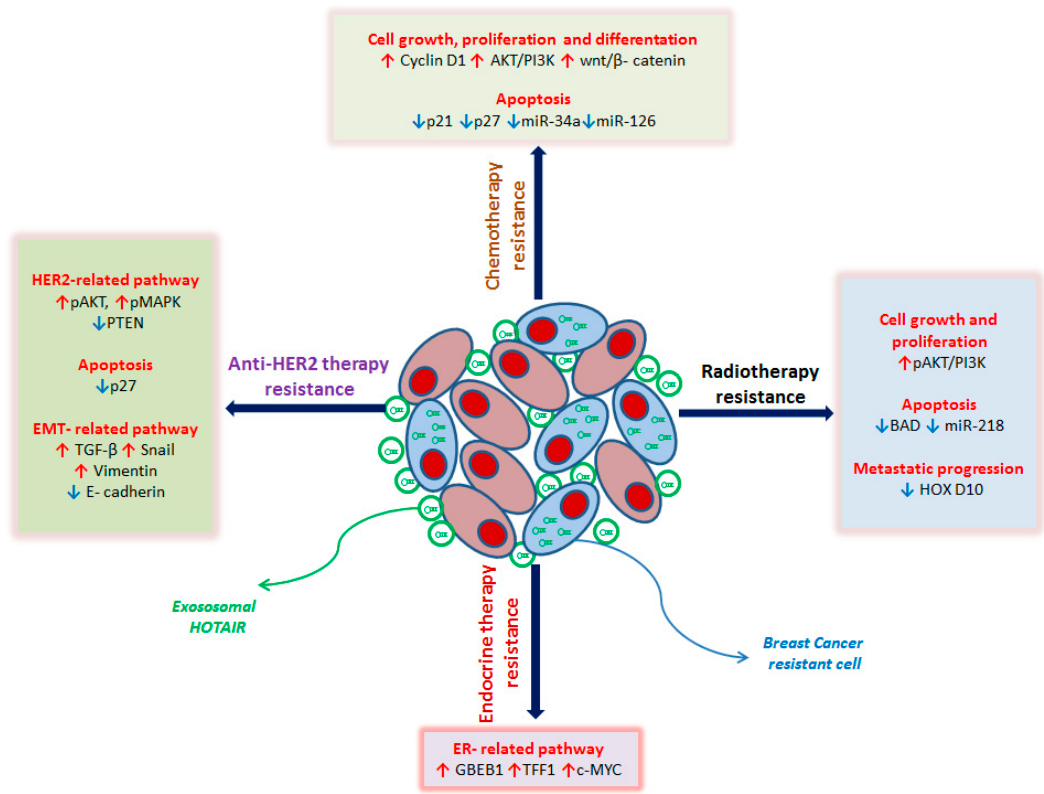
Figure 1. Schematic representation of HOTAIR role in breast cancer (BC) drug resistance mechanisms with details of the main molecular pathways involved. In anti-HER2 treatment-resistant BC cells, the overexpression of HOTAIR leads to: (i) deregulation of HER2-related genes by upregulating the signal transduction pathway PI3K-Akt and downregulating the tumor suppressor gene PTEN with the consequent increase in proliferation, cell growth, and survival; (ii) inhibition of apoptosis by the downregulation of cyclin-dependent kinase inhibitor p27; (iii) induction of EMT by TGF- β , Snail and Vimentin upregulation, and decrease in E-cadherin expression. In endocrine therapy resistant BC cells, the overexpression of HOTAIR leads to the repression of ER and the activation of ER-responsive genes, such as GREB1, TFF1 , and c-MYC , promoting cell proliferation. In BC radio- resistant cells, the overexpression of HOTAIR leads to: (i) promotion of cell growth and proliferation by upregulation of the PI3K-Akt pathway; (ii) blockage of apoptosis by downregulating the pro- apoptosis gene BAD and miR-218, normally involved in the repair of radiation-induced DNA damage; (iii) induction of metastatic spread by silencing of HOXD10 , a metastasis suppressor gene.